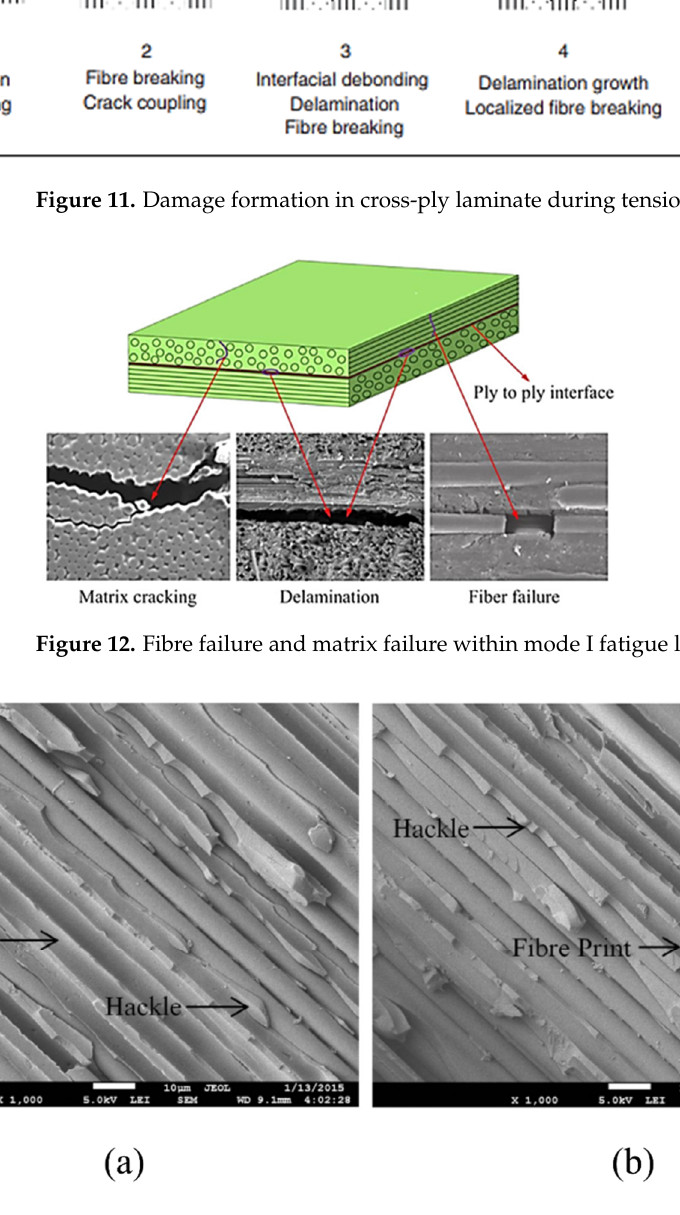
Figure 13. SEM images of fractured surfaces under mode I fatigue loading( a ) at short crack length ( b ) at long crack length. ( b ) at long crack